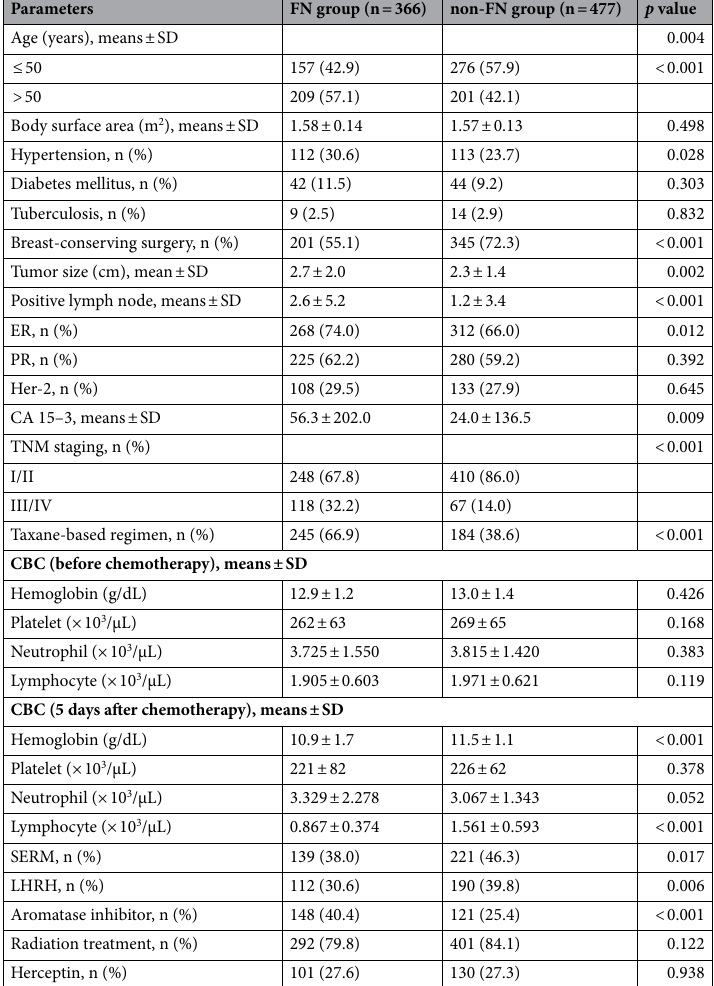
Table 1. Clinical demographic characteristics of patients with and without febrile neutropenia in the training dataset. FN febrile neutropenia, SD standard deviation, BSA body surface area, ER estrogen receptor, PR progesterone receptor, Her-2 human epidermal growth factor receptor 2, CA cancer antigen, CBC complete blood count, SERM selective estrogen receptor modulator, LHRH luteinizing hormone-releasing hormone, F/U